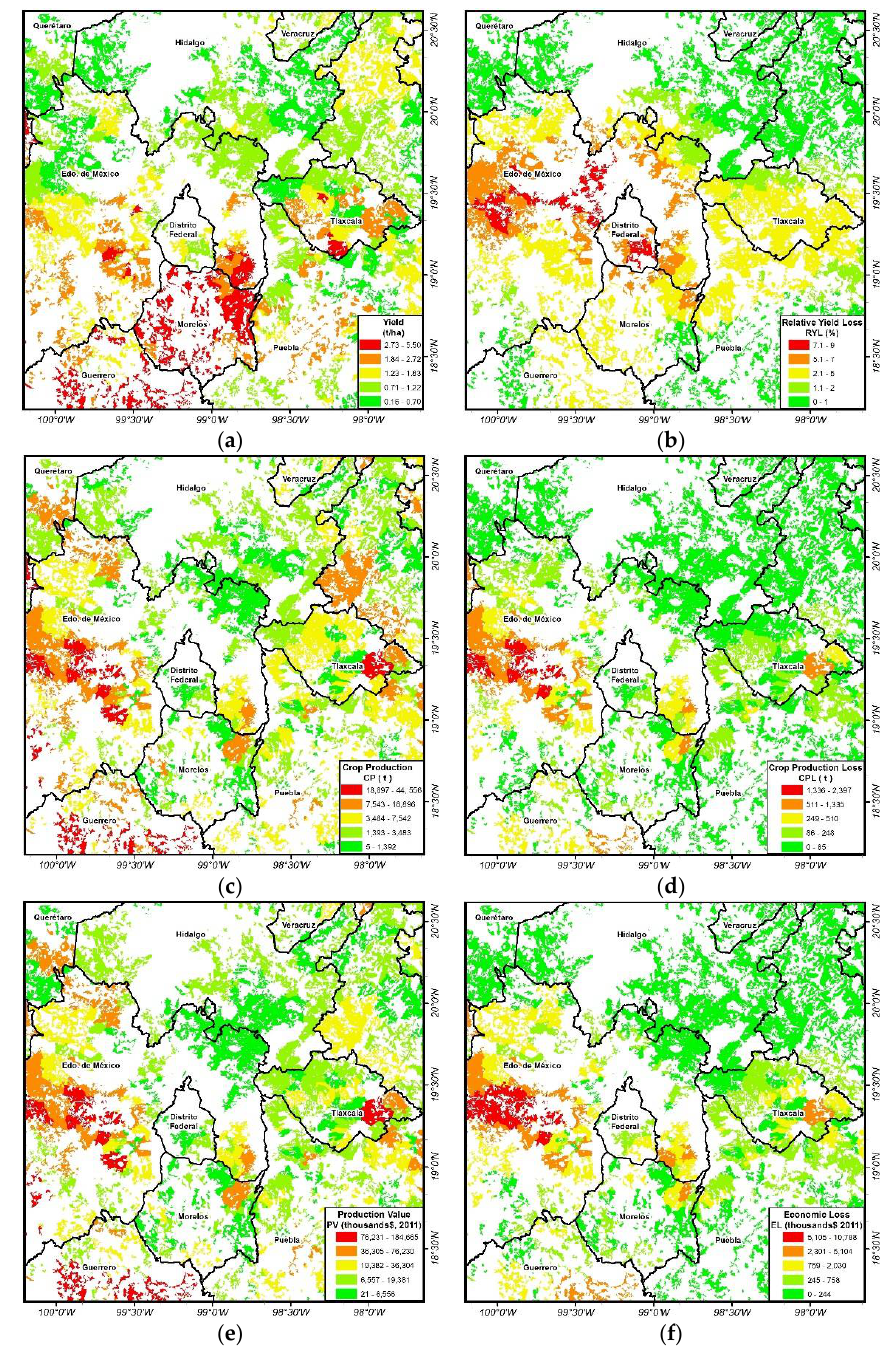
Figure 5. Maize: ( a ) Yield (t/ha). ( b ) Relative yield loss (%). ( c ) Production (t). ( d ) Crop production loss (t). ( e ) Production value (MXN). ( f ) Economic loss (MXN), for 2011.